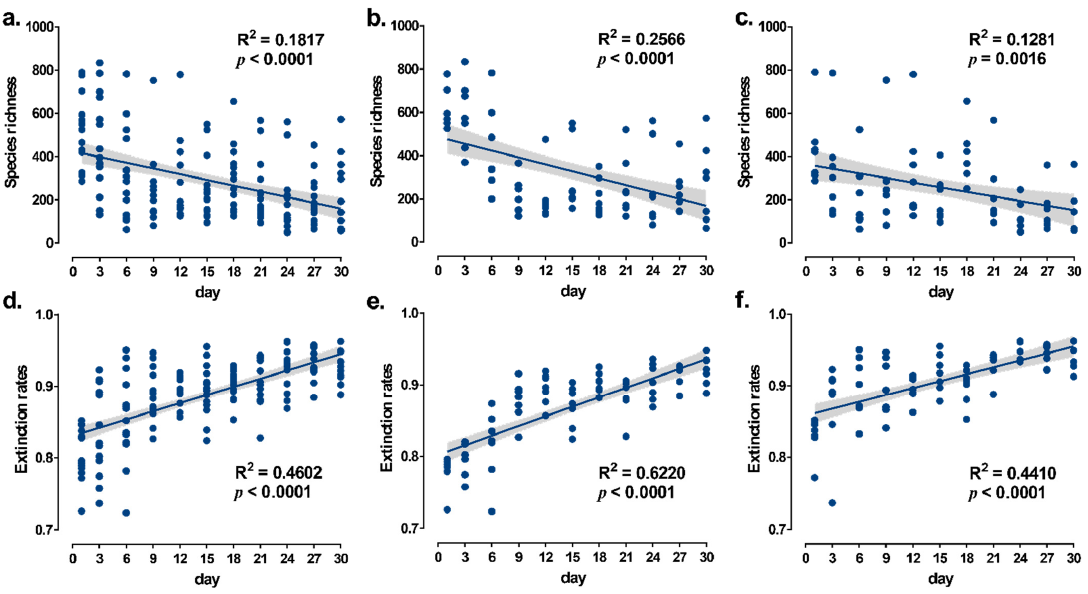
Figure 5. Linear relationships between microbial species richness and extinction rates in the micro- cosm system and time. ( a – c ) are linear relationships between species richness and microcosm establishment time for the overall positive and negative groups, respectively; ( d – f ) are the linear relationships between extinction rates and microcosm establishment time for the overall positive and negative groups, respectively. The solid line in the figure shows the linear regression model and the grey shading is the 95% confidence interval.